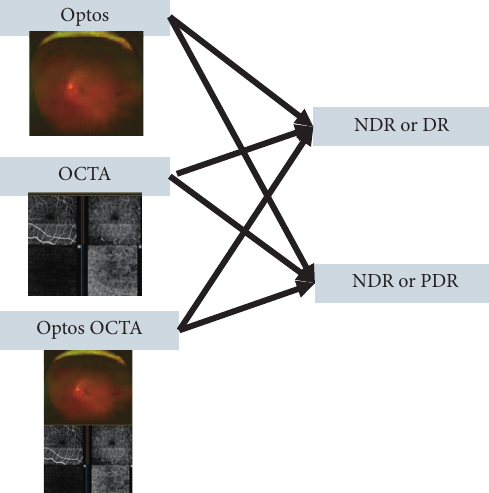
Figure 1: Identification of each image and stage. Test 1 (no apparent diabetic retinopathy [NDR] or diabetic retinopathy [DR]) and test 2 (NDR or proliferative diabetic retinopathy [PDR]) were performed using the Optos, optical coherence tomography angiography (OCTA), and Optos OCTA